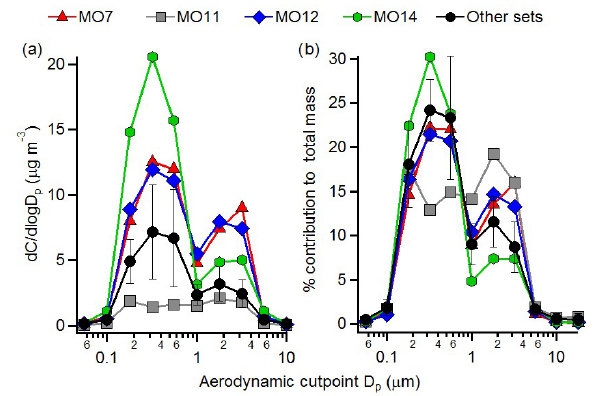
Figure 5. (a) Mass size distributions for total water-soluble mass ( C is the sum of mass concentrations for water-soluble species) and (b) percent contribution of each size range to the total water-soluble mass for the three MOUDI sets with the highest aerosol mass con- centrations (MO7, MO12, and MO14), the set with the lowest con- centration (MO11), and the average ( ± 1 standard deviation error bars) for the remaining eight sets.